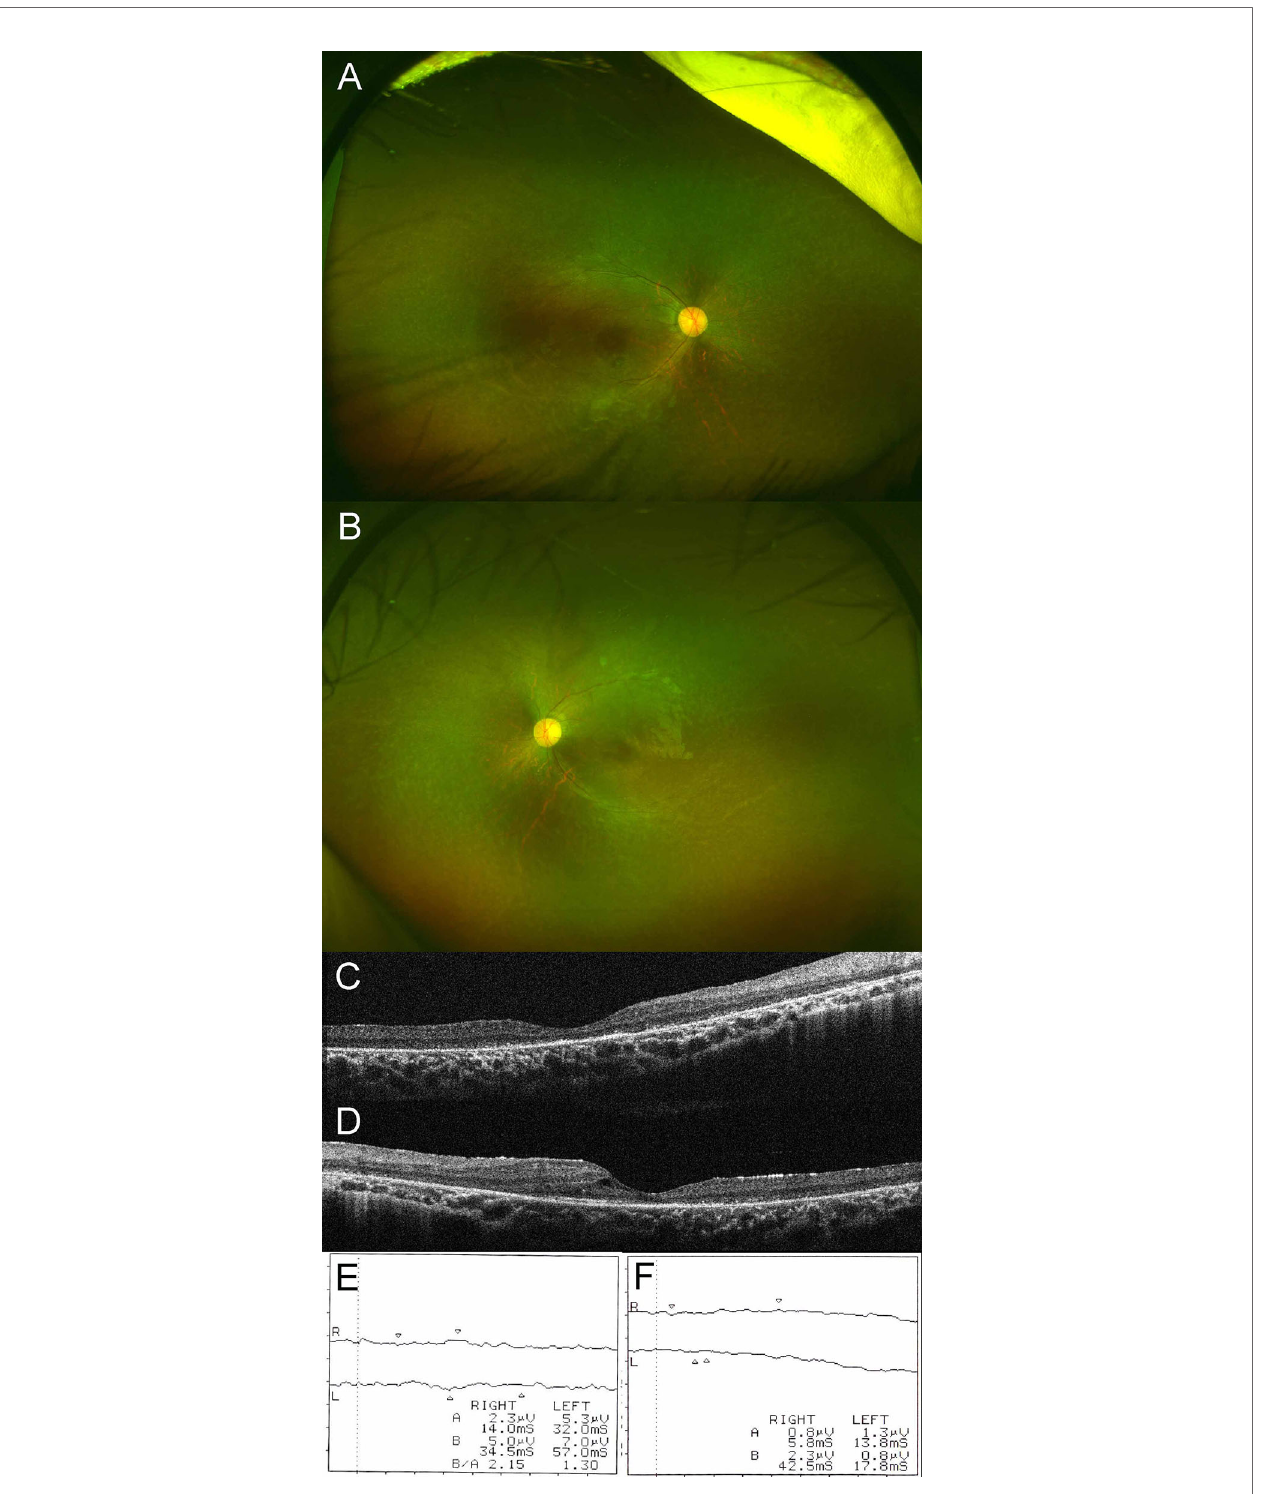
FIGURE 1 | Ultra-wide fi eld fundus photograph of right (A) and left (B) eyes. Dilated fundus examination disclosed vascular attenuation, optic disc pallor, and retinal pigmentary changes in both eyes. Macular optical coherence tomography of right (C) and left (D) eyes. Macular optical coherence tomography demonstrated marked disruption of the external limiting membrane and an ellipsoid zone in both eyes, with small foveal cysts in the left eye. Results of scotopic (E) and photopic (F) electroretinograms. Scotopic and photopic electroretinograms showed no recordable responses in either